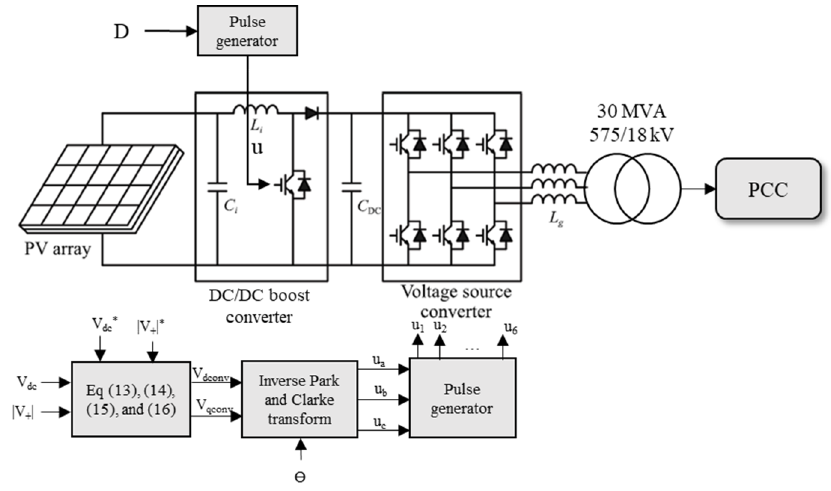
Figure 6. Array control through DC/DC boost converter and inverter control.